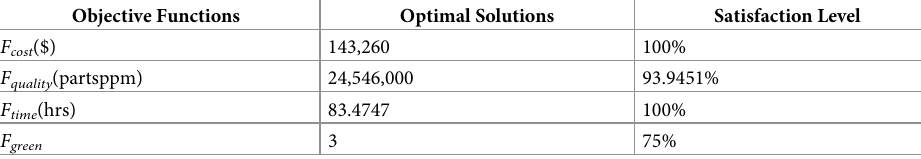
Table 14. Optimal solutions to objective functions.